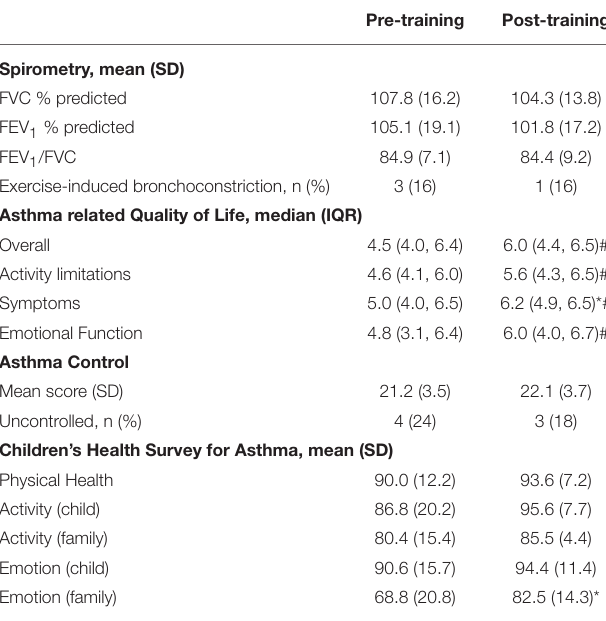
TABLE 3 | Asthma characteristics. TABLE 4 | Lipid levels before and after exercise